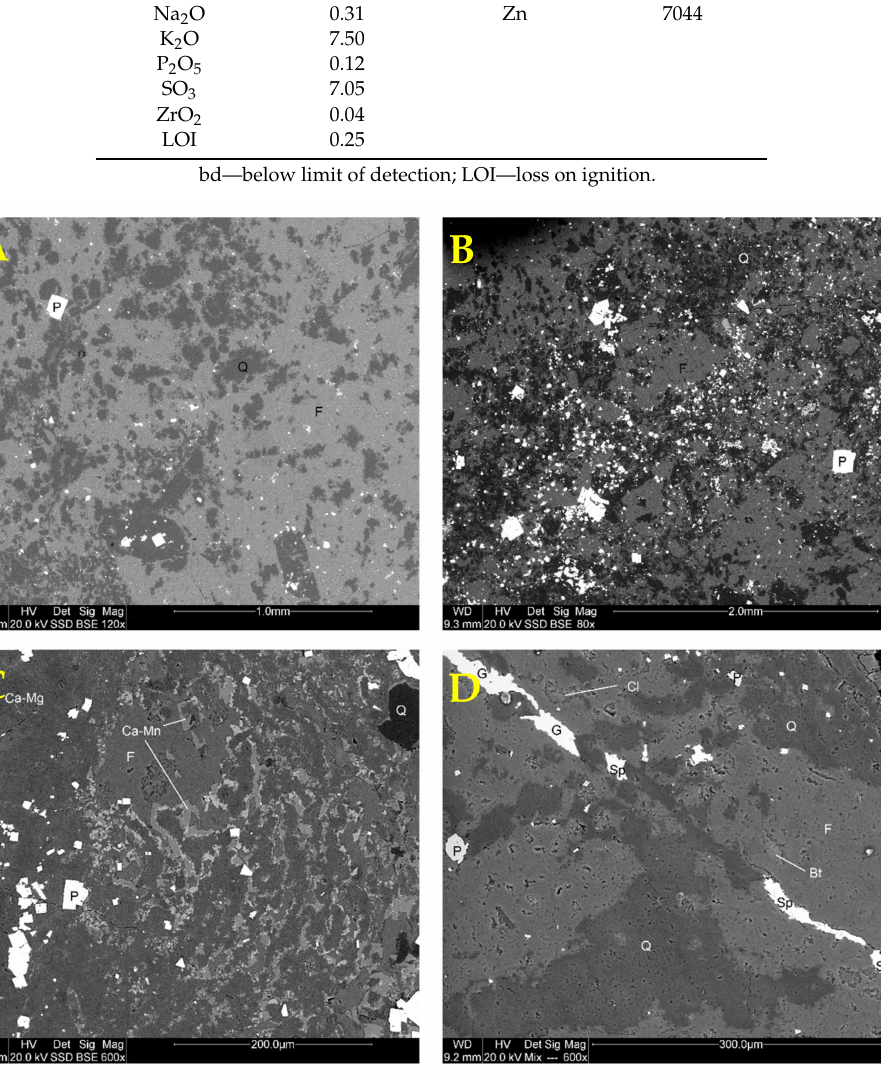
Figure 3. Back-scattered electron images (BSE) of the waste rock. ( A ) structure of a typical pyrite-poor area, ( B ) structure of pyrite-rich area, ( C ) carbonate-rich area, ( D ) typical vein infilling with minor Zn and Pb sulfides. Explanations: Q—quartz, F—potassium feldspar,